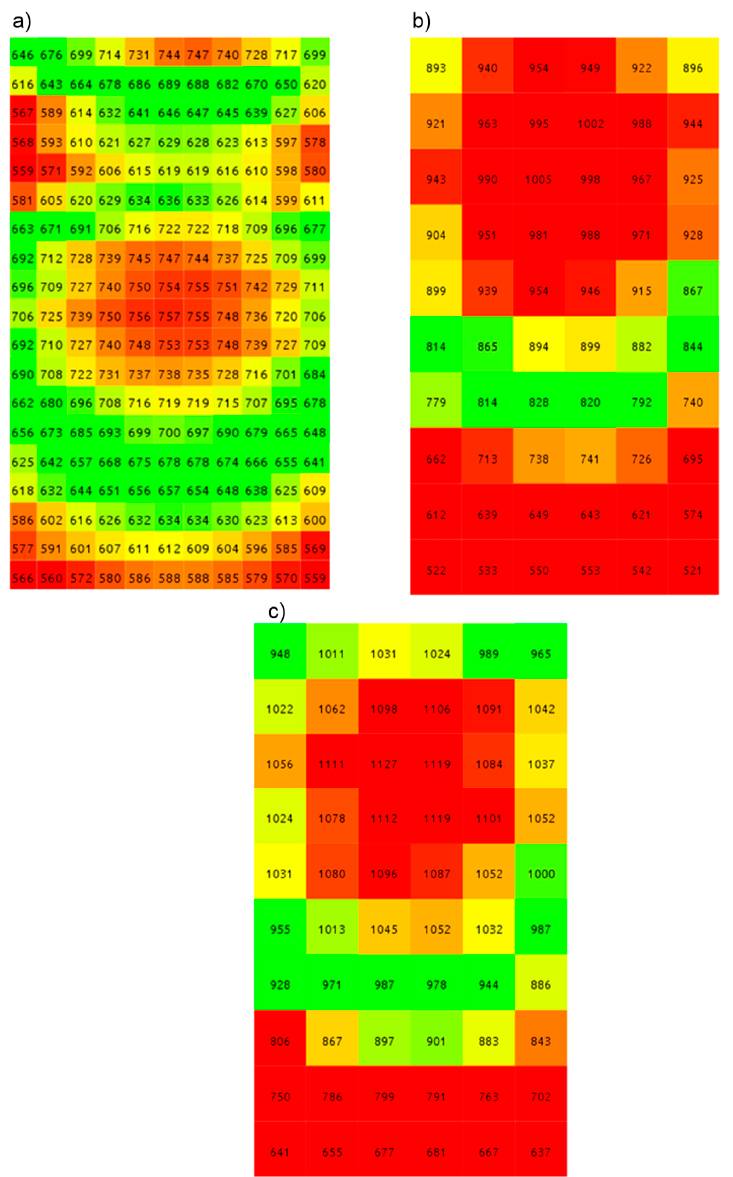
Figure 12. Distribution of solar radiation intensity on the surface comprising the tested samples. ( a ) distribution for artificial sun slope of 43.28°—minimum intensity 665 W/m 2 , maximum 757 W/m 2 , medium 665 W/m 2 , ( b ) distribution for artificial sun slope of 21.0°—minimum intensity 521 W/m 2 , maximum 1005 W/m 2 , medium 827 W/m 2 , ( c ) distribution for artificial sun slope of 16.28°—minimum intensity 637 W/m 2 , maximum 1127 W/m 2 , average 955 W/m 2 .